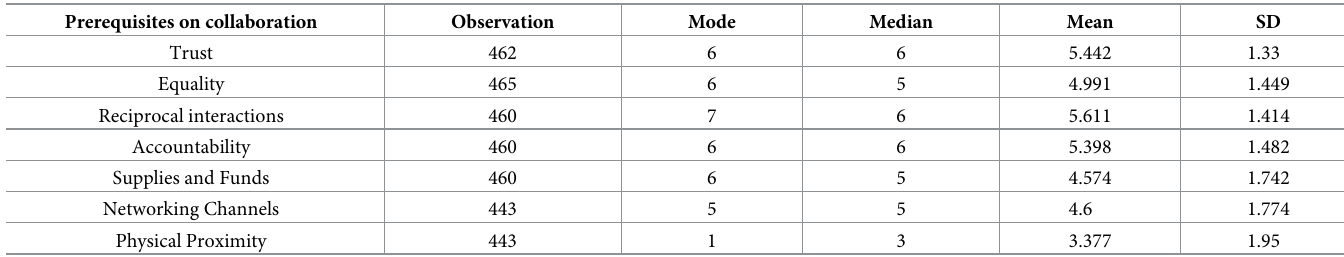
Table 2. The perceived importance on each prerequisite.